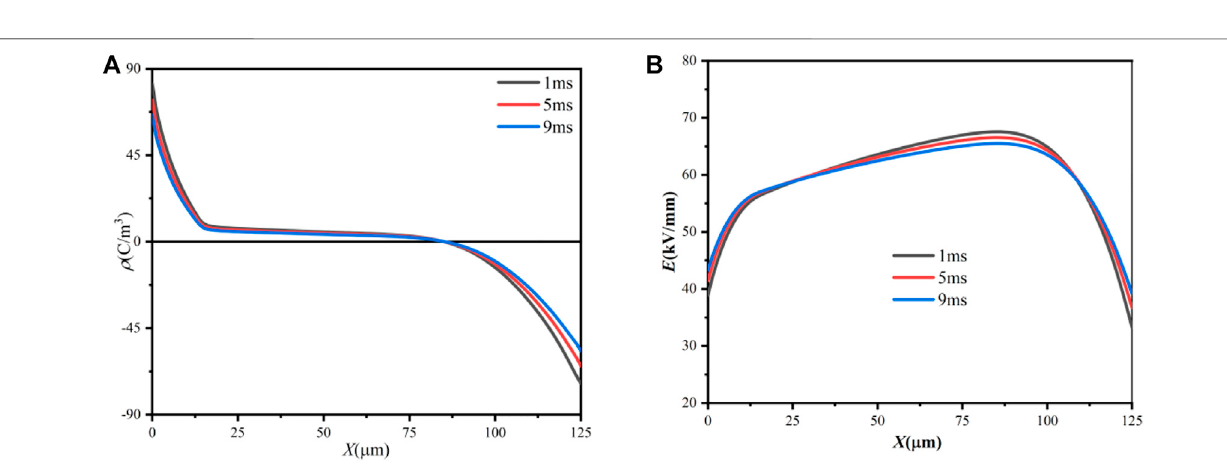
Frontiers in Materials |